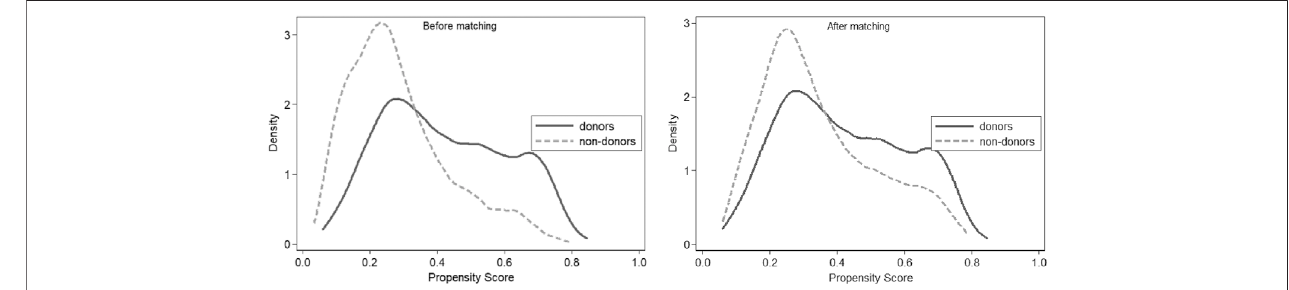
FIGURE 2 | Density function